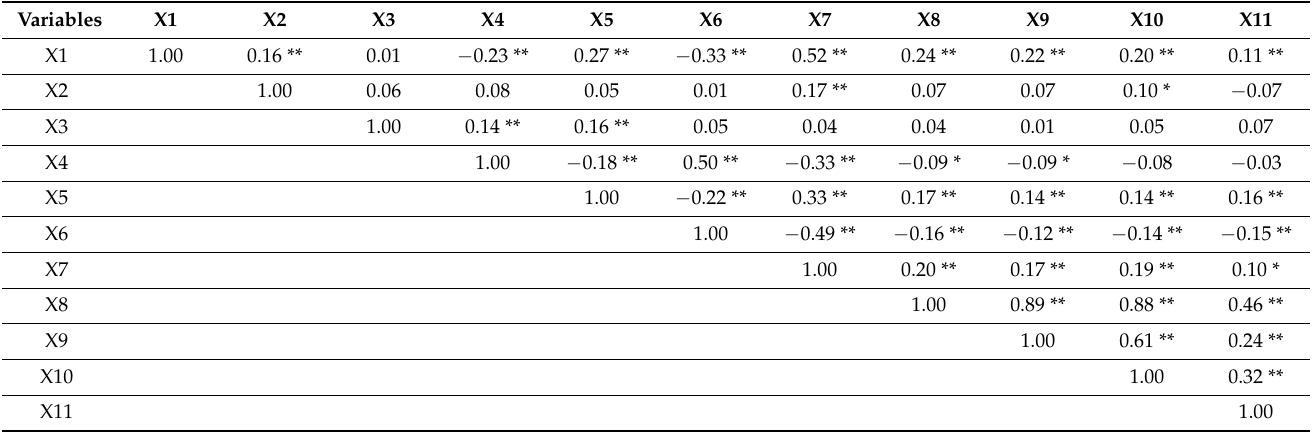
Table 3. Inter-correlations for the screening intention and some variables.